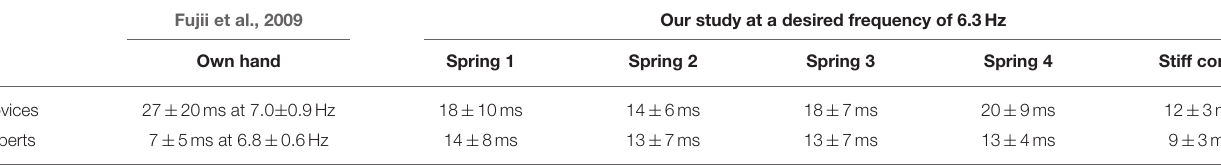
TABLE 3 | Comparison of imprecision (Equation2) at maximum drumming frequency between Fujii et al. (2009) and our study (mean ± SD).